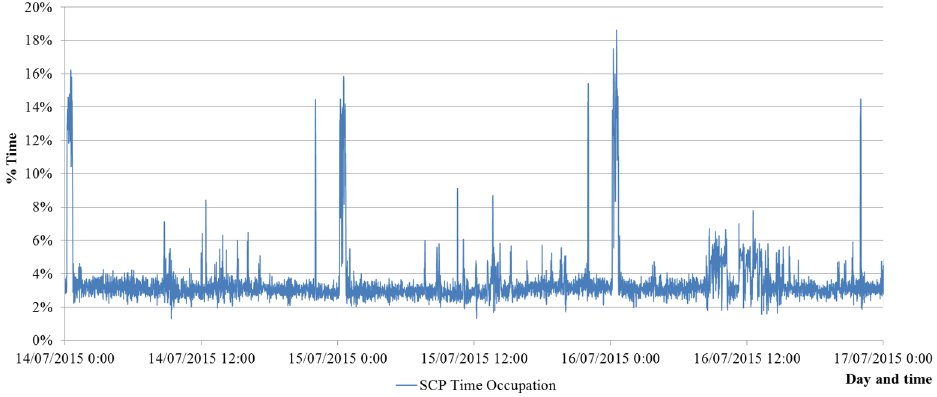
Figure 11. PLC channel occupation in a subnetwork.